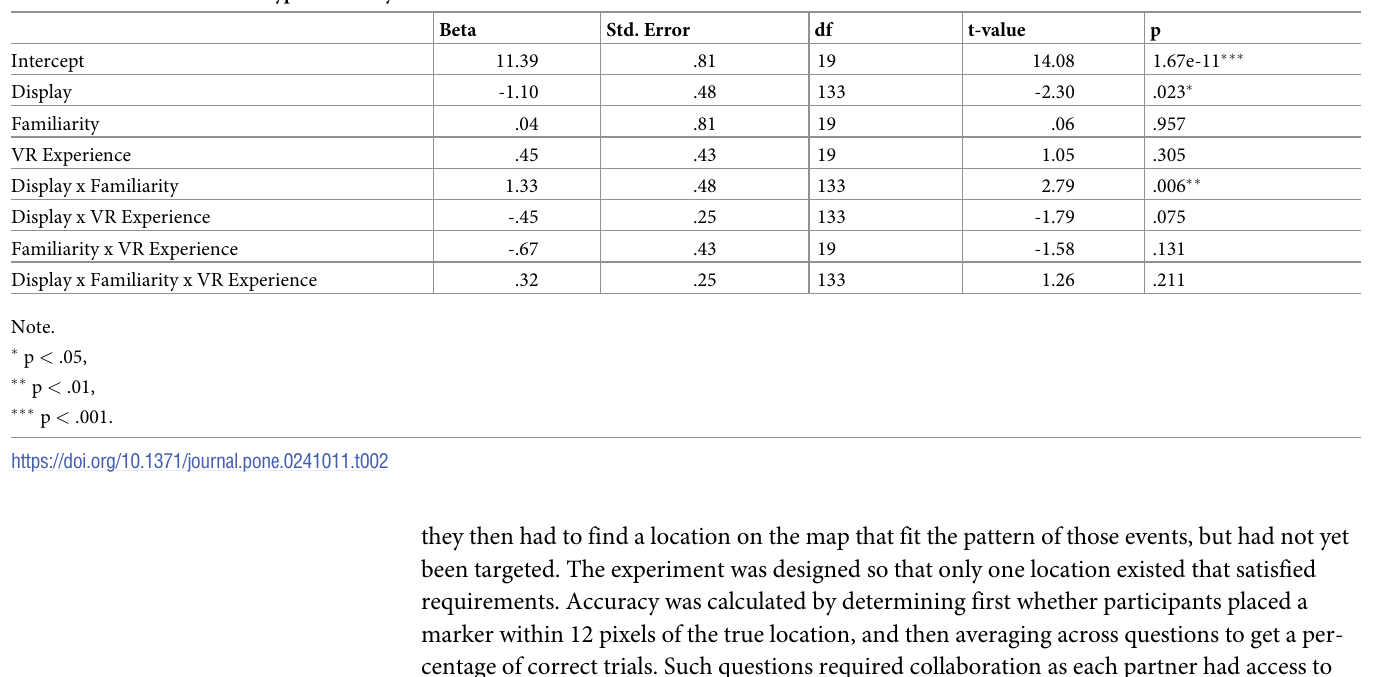
Table 2. Full model results for type 2 accuracy.